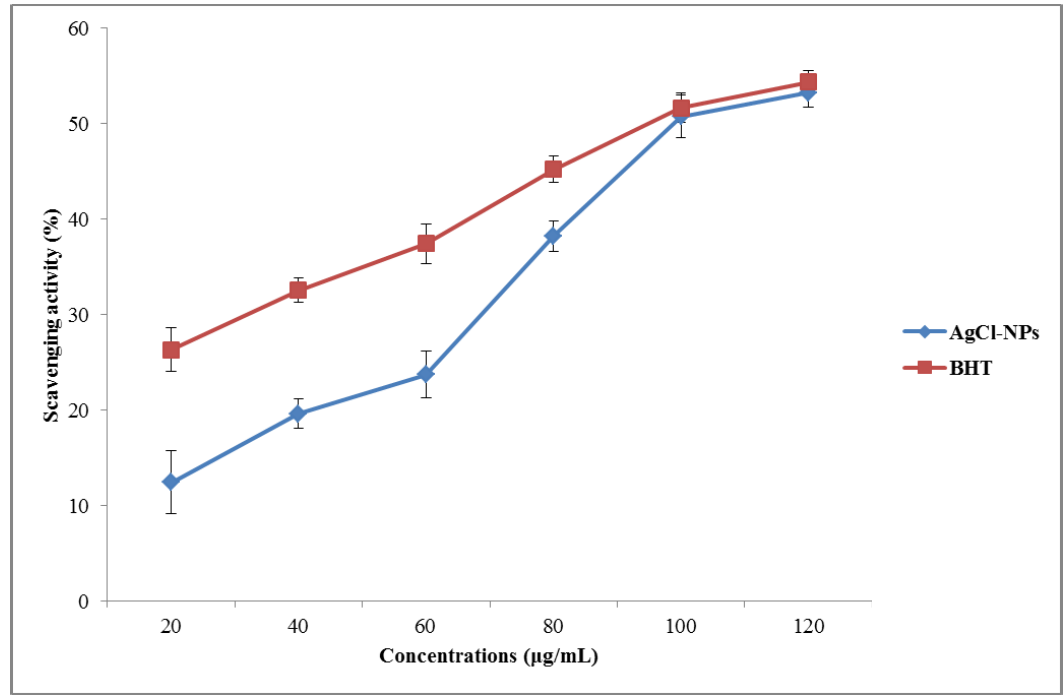
Figure 8. Antioxidant activity of biosynthesized AgCl-NPs from the Pulicaria vulgaris aerial part extract.